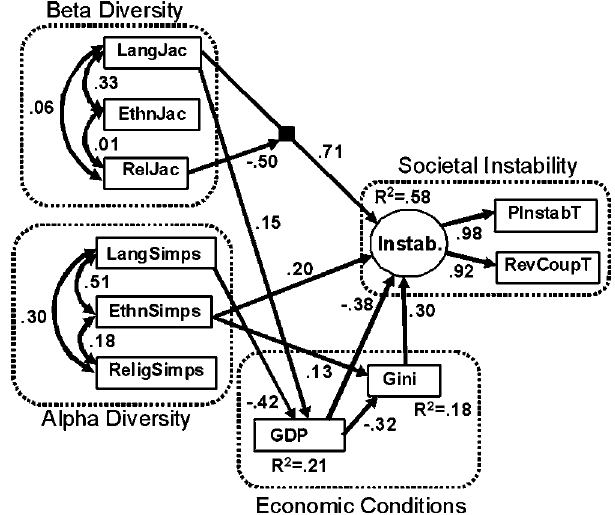
Figure 2. SEM results, indicating the relationships between variables and constructs (dotted boxes). Model X 2 =31.7 with 34 df, p=0.581 (indicating close fit between model and data). Coefficients shown are standardized